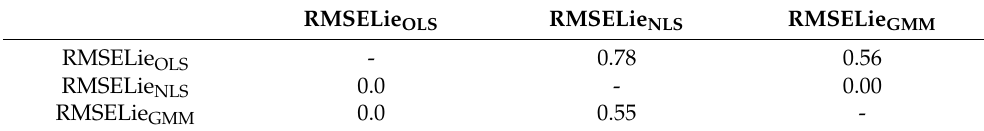
Table 7. Diebold–Mariano results.